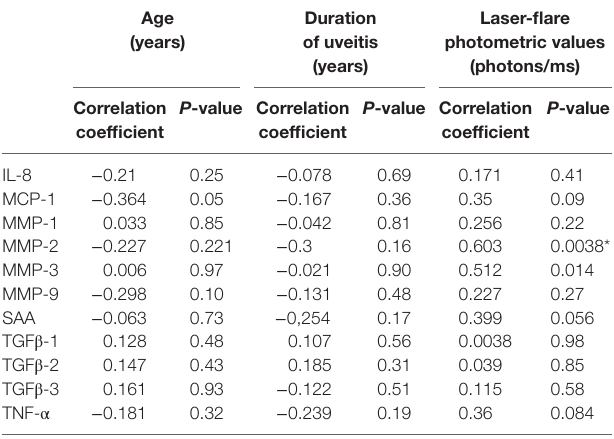
Table 3 | Correlation of cytokines with age, duration of uveitis, or laser-flare values. age (years)